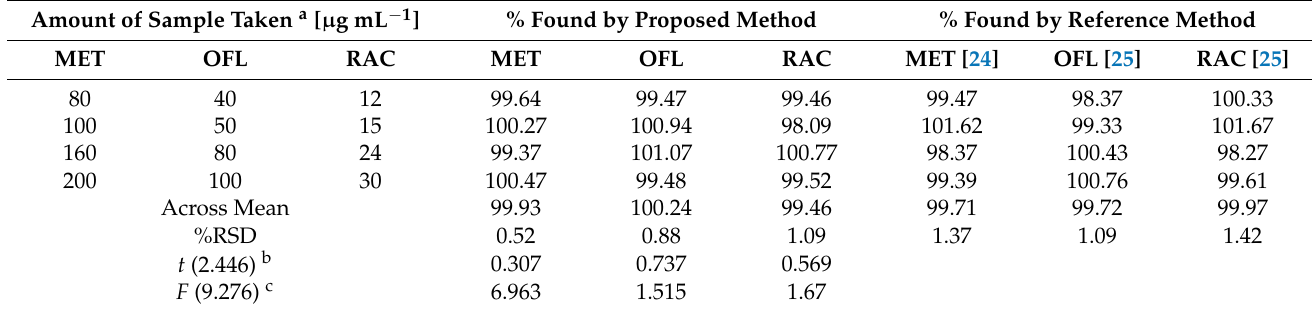
Table 3. Analysis results of drugs from formulations by optimized HPLC